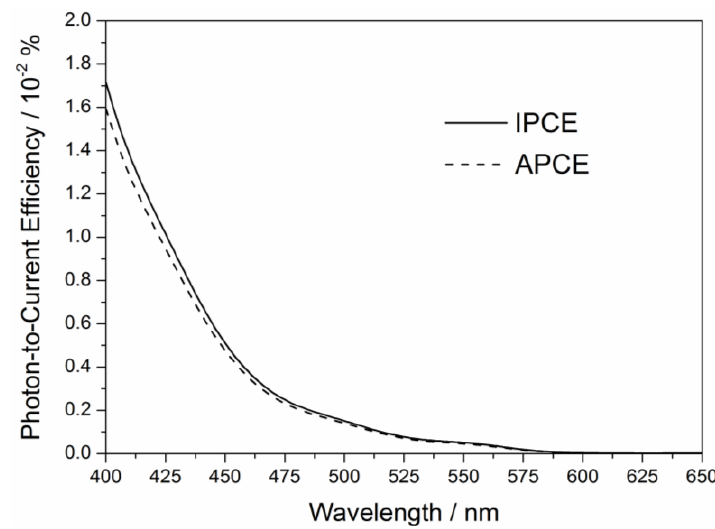
Figure 2. IPCE and APCE of the ZFO photoanode with x ≈ 0.20 measured under an externally applied bias of +1.2 V vs . RHE in a 50% v/v methanol aqueous solution containing 0.1 mol L −1 KNO 3 . A monochromator was used for fine-tuning the wavelengths of the analyzing light to a final resolution of 1 nm.